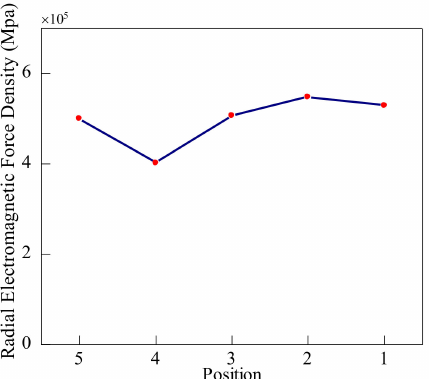
Figure 15. Radial electromagnetic force density of five selected points when W = 0.7 mm. Figure 16a compares the radial air-gap flux density before and after optimization design. The amplitude of the radial electromagnetic force density at position 3 is e ff ectively reduced after optimization, as shown in Figure 16b.